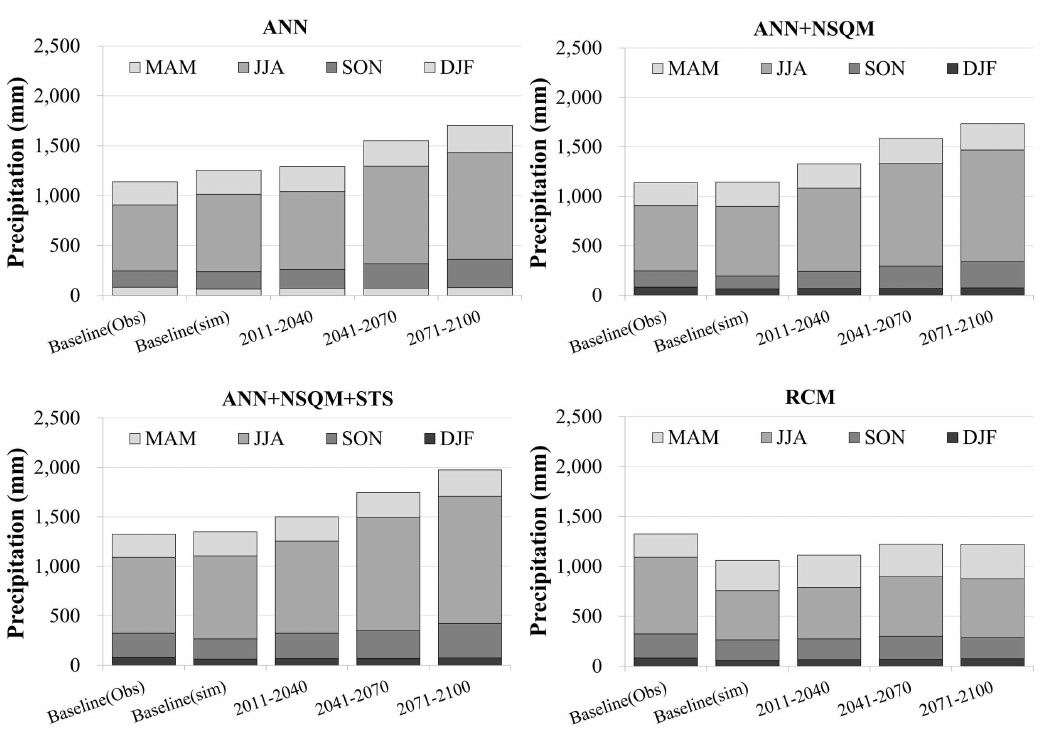
Figure 7. Downscaled seasonal precipitation projection by stages of composite downscaling modules. Table 6. Rate of projected precipitation increase by stages of composite downscaling